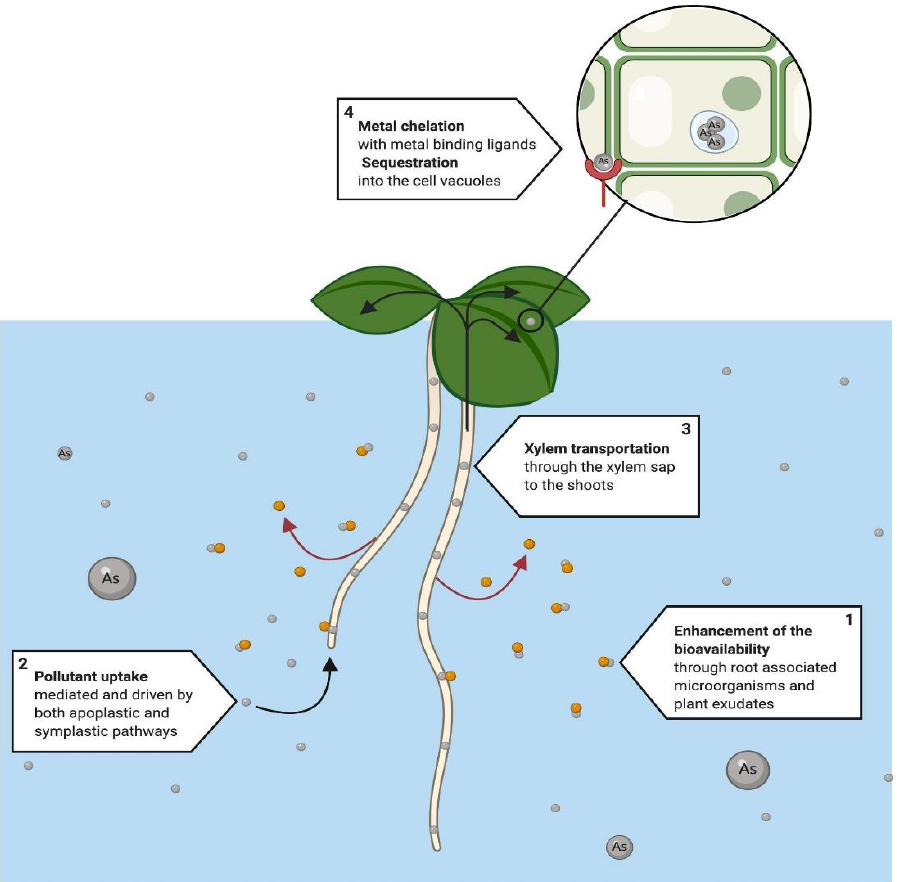
Figure 3. Proposed phytoextraction system that has been mainly used for the removal of heavy metals, such as arsenic (As). The process initiates with the root uptake of the metals (1). Prior to absorption, (2) the bioavailability of metals can be enhanced through root associated microorganisms and plant root metabolites, to improve in the phytoextraction process. Once the metal is available, (3) it is mobilized to shoots and leaves, through the xylem sap. Finally, (4) the pollutant is chelated and sequestered by the cell into the cell vacuoles where it will later will be harvested within the plant tissue for proper disposal. [113–115].